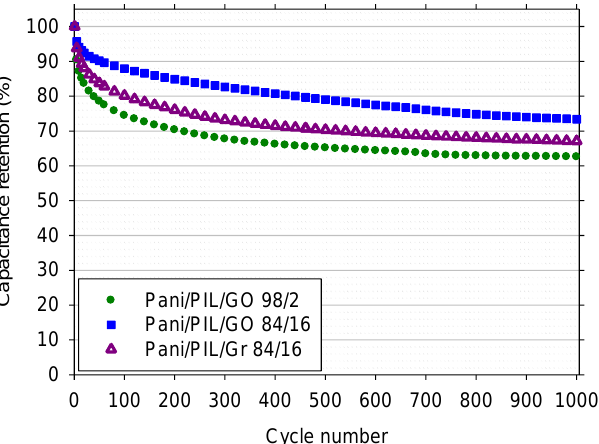
Figure 7. Cycling stability at 2 A·g − 1 of PANI/PIL/GO 98/2 and PANI/PIL/Gr 84/16 nanocomposites in H 2 SO 4 1 mol·L − 1 .